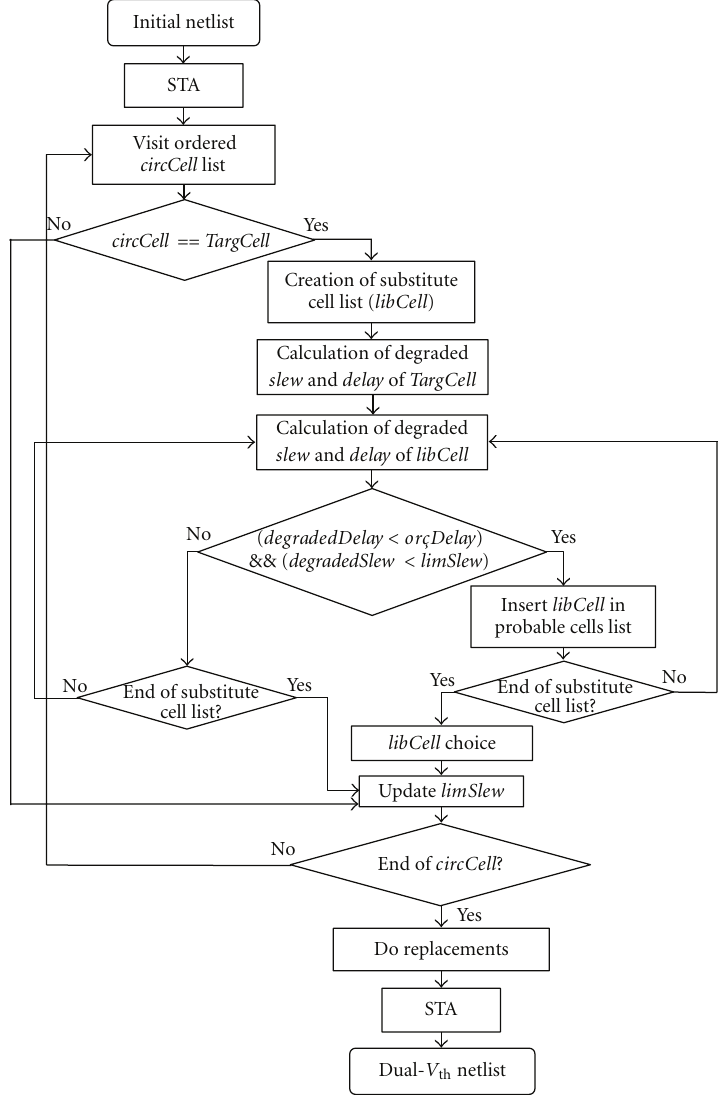
Figure 4: Detailed algorithm